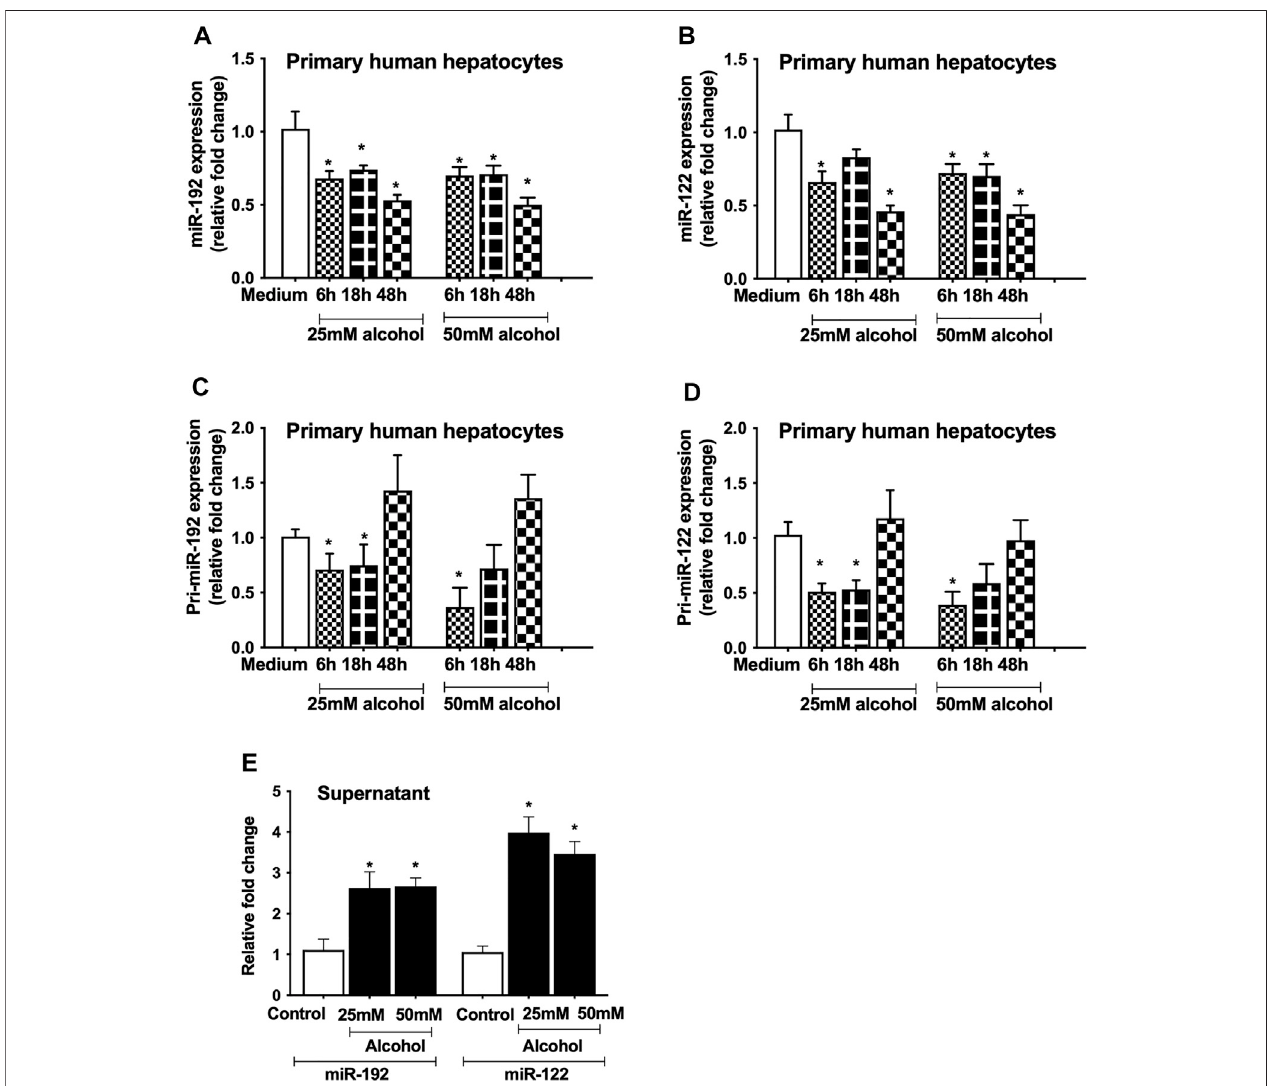
FIGURE3| AlcoholregulatesmiRNA expressionatthetranscriptionallevel.Primaryhumanhepatocyteswereculturedandtreatedwithdifferentdosageofalcohol (25and50 mM)forindicatedtimes.ThelevelsofmatureformofmiR-192 (A) andmiR-122 (B) weremeasuredbyqPCRandRNU48wasusedasanormalizationcontrol. The primary transcripts of miR-192 (C) and miR-122 (D) were quanti fi ed by qPCR and GAPDH was used as a normalization control. Total RNA was extracted from the cell-free supernatants of primary hepatocytes and miR-192 and miR-122 were evaluated 18 h after alcohol treatment by qPCR and spiked synthetic Cel-miR-39 was used as a normalization control (E) . Data represent mean ± SEM. Mann-Whitney test was employed for statistical analysis. *indicates p < 0.05 versus control cells.